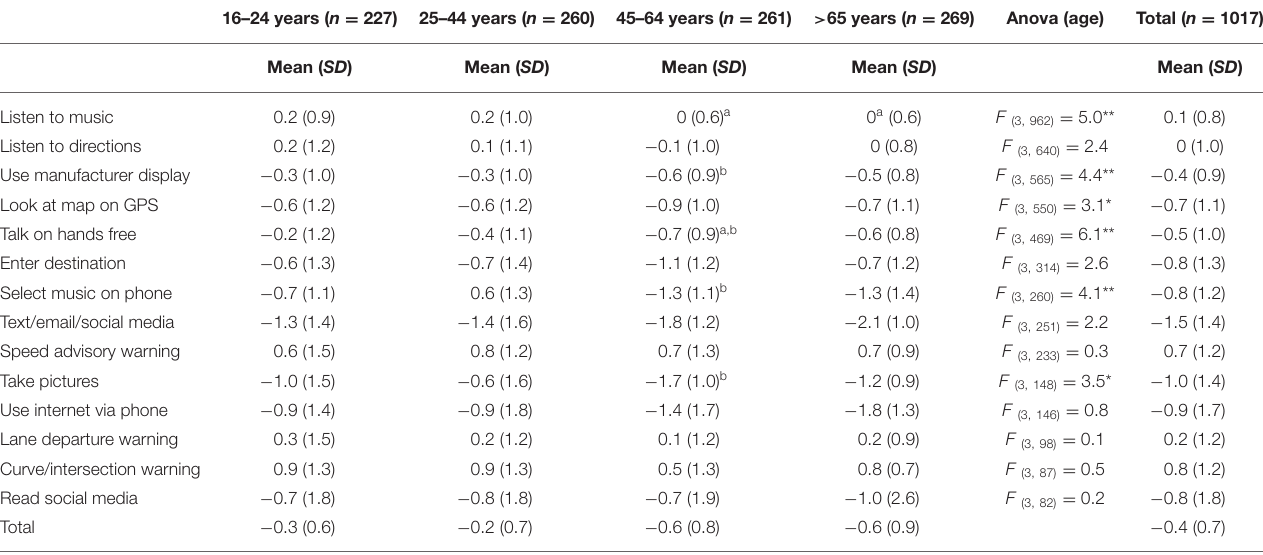
TABLE 9 | The mean and standard deviation of the driving safety ratings by age group for the respondents engaging in each IVIS behavior or event (ratings were from − 3 very impaired to + 3 very